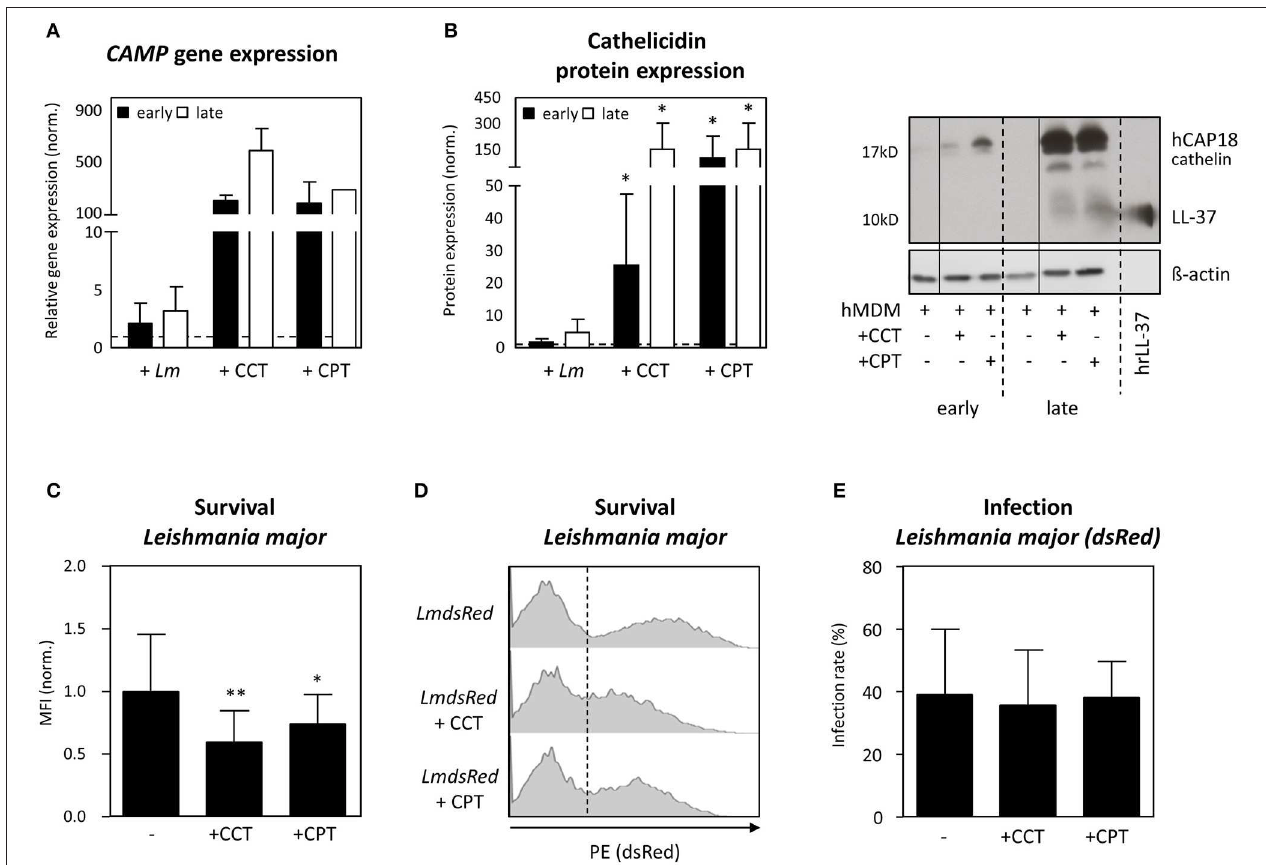
FIGURE 4 | Vitamin-D derivatives induce LL37 mediated Leishmania restriction in human primary macrophages. hMDM-1 were generated and treated with calcitriol (CCT) or calcipotriol (CPT) for 24h, or left untreated. Subsequently, hMDM-1 were infected with transgenic dsRed expressing Lm or Lae (MOI10). After 3h, extracellular parasites were removed by washing, following incubation at 37 ◦ C, 5% CO 2 . After 24h (early; black bars) or 6 d (late; white bars) CAMP gene ( n = 1–5) (A) and cathelicidin protein expression ( n = 5–7) (B) were by qRT-PCR and western blot analysis. CAMP expression was normalized against the house keeping gene GAPHD . Western blots were analyzed by densitometry (ImageJ analysis), normalizing cathelicidin against ß-actin protein expression. Gene and protein expression were normalized to the untreated control, which was set to 1 (dashed line). In addition, parasite survival (C,D) and infection rates of Lm dsRed (E) , analyzed by the mean fluorescent intensity (MFI) of the dsRed protein, was assessed by flow cytometry. Western blots, FACS histograms and data, presented as mean ± SD, are representative for at least 3 independent experiments (Wilcoxon matched-pairs signed rank test; * p < 0.05; ** p < 0.01).